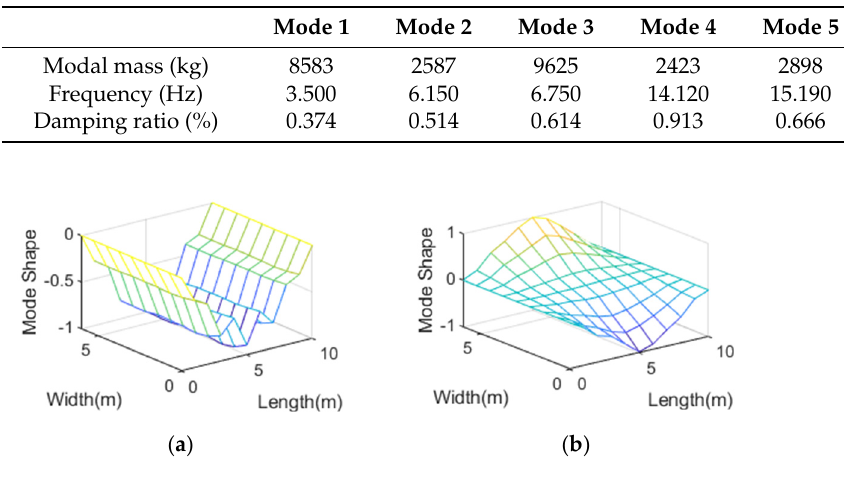
Table 1. Dynamic properties of the structural model.